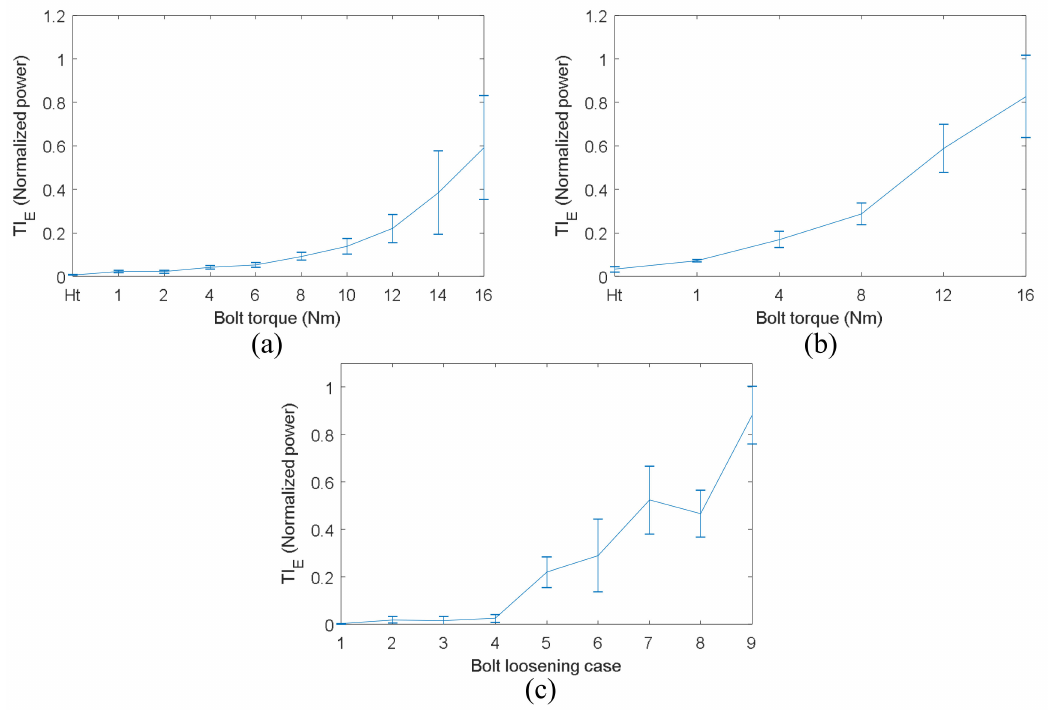
Figure 15. Results of TIE: ( a ) TI E versus bolt torque in the single bolt structure; ( b ) TI E versus torque of bolt 2 in the four-bolt structure; ( c ) TI E versus bolt loosening case in the four-bolt